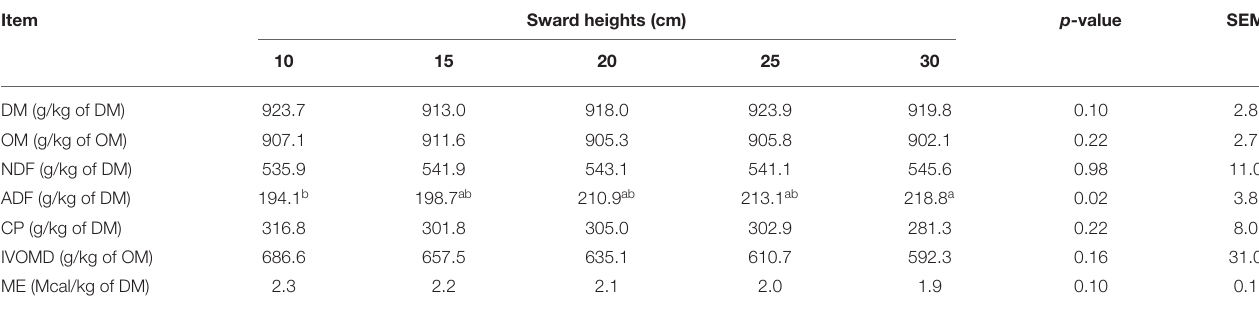
TABLE 2 | Chemical composition and in vitro organic matter digestibility (IVOMD) of herbage samples from the top stratum of five Kikuyu sward heights.